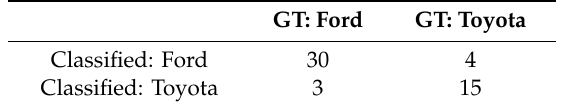
Table A1. Confusion matrix for the IMG429 video: 0% missing pixels trial with YOLO classification.